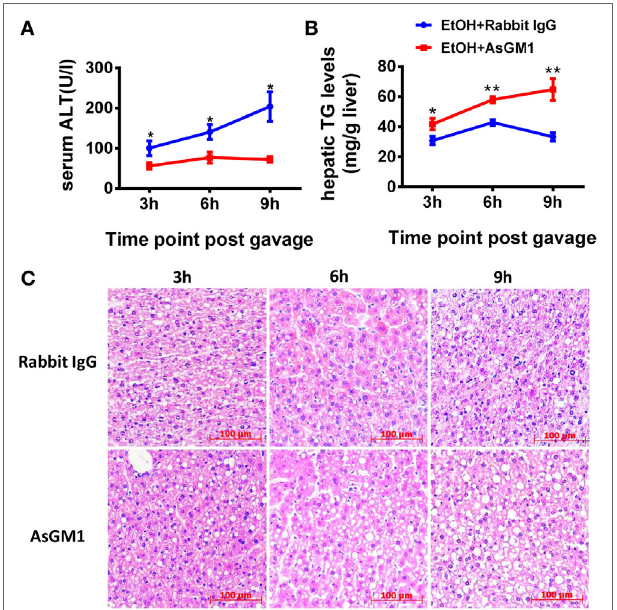
FigUre 2 | Deficiency of natural killer (NK) cells promoted liver steatosis but ameliorated inflammation at different time points. (a) Pair- or ethanol-fed wild-type C57BL/6 mice were treated with anti-asialo GM1 or control rabbit IgG once every 3 days as described in Section “Materials and Methods” to deplete NK cells. The mice were euthanized 3, 6, or 9 h after gavage. Liver injury and steatosis were evaluated based on (a) serum alanine aminotransferase and (B) liver triglyceride levels and (c) liver tissue hematoxylin and eosin staining (original magnification, 200 × ). The data are representative of two independent experiments and are shown as the mean ± SEM ( n = 4–6). * P < 0.05; ** P <